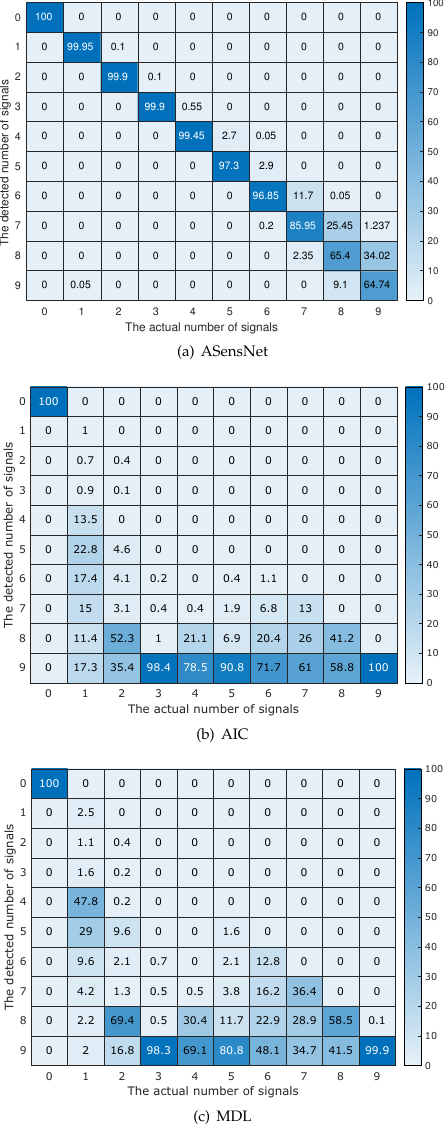
Figure 7. Confusion maps of ASensNet, AIC, and MDL for the SNR of 6dB. Therefore, this realistic evaluation confirms that our proposed scheme can accurately detect the number of asynchronously transmitted signals even if the SNRs of the signals vary.